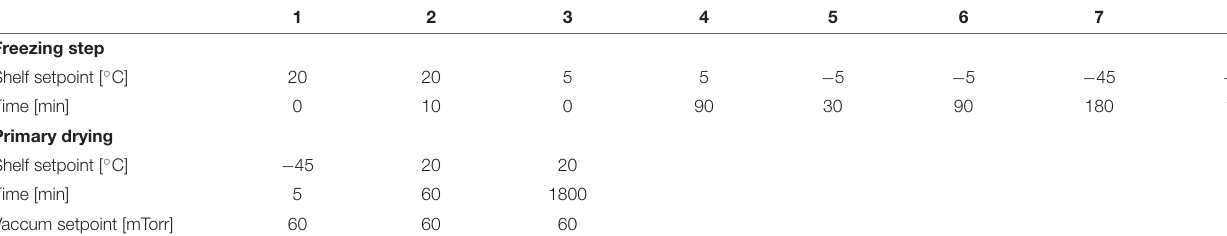
TABLE 7 | Freeze drying recipe used for 3% w/v mannitol